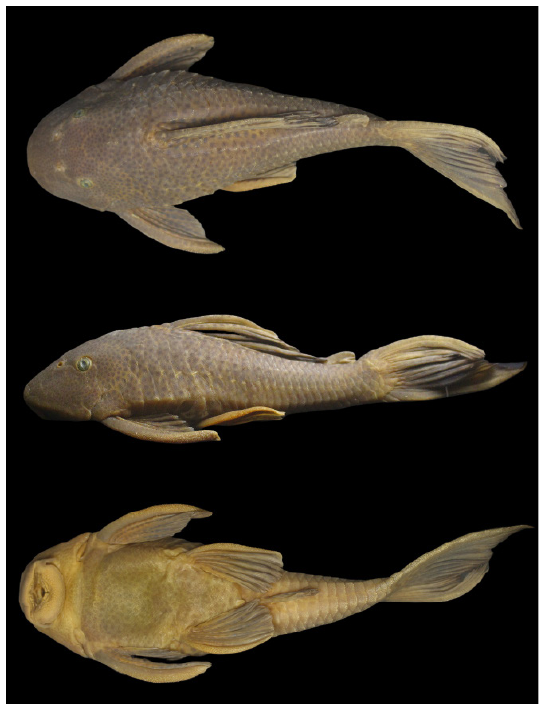
FIGURE 9 | Hypostomus pusarum , UFPB 9265, 150.0 mm SL. Poti River, tributary of the Parnaíba River basin, Crateús, Ceará,